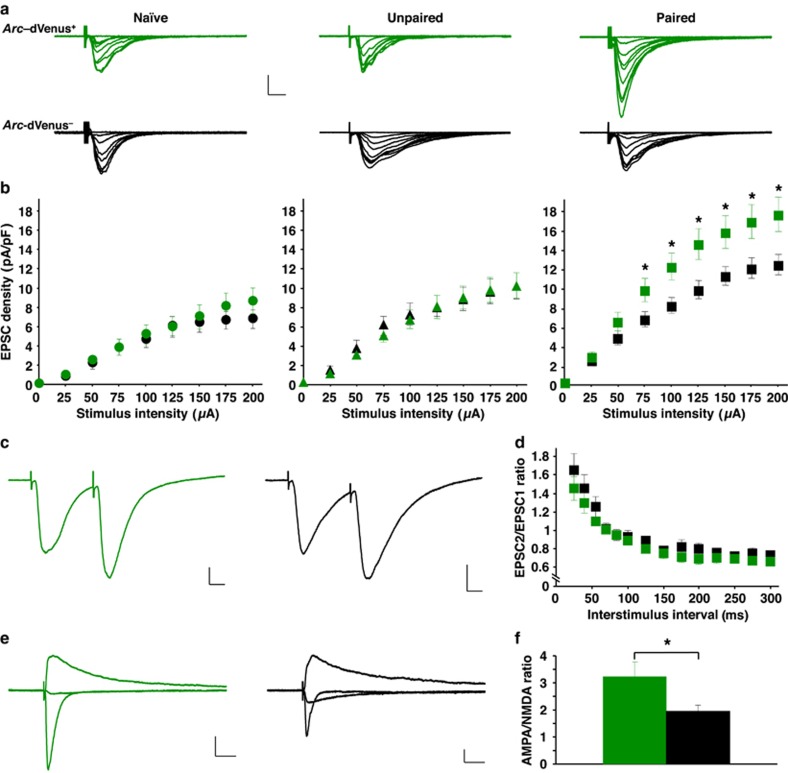
Synaptic potentiation is learning-specific and highly localized to Arc+ neurons. (a) Superimposed averages (5 traces) of EPSCs evoked via thalamic input stimulation (0–200 μA, 25 μA increments) at a holding membrane potential of −70 mV. Stimulus artifacts are truncated. Arc-dVenus+ neurons (top) display strongly potentiated evoked EPSCs specific to the paired (right) versus naïve (left) or unpaired (center) conditions. Scale bars: 200 pA, 10 ms. (b) Input-output curves for naïve (left), unpaired (center) and paired (right) conditions. In the naïve and unpaired conditions, EPSCs recorded from Arc-dVenus+ (naïve: n=13, unpaired: n=19; green) and Arc-dVenus− (naïve: n=14, unpaired: n=18; black) neurons are similar. In contrast, EPSCs are selectively potentiated in Arc-dVenus+ neurons in the paired condition (n=34, green) compared with neighboring Arc-dVenus− neurons (n=34, black), across all stimulus intensities >50 μA. Naïve: n=12 mice, Unpaired: n=12 mice, Paired: n=21 mice. Repeated measures analysis of variance, stimulus intensity × Arc-dVenus interaction: naïve, F=0.88, P=0.39; unpaired, F=0.28, P=0.69; paired, F=5.26, P<0.01. (c) Averages (5 traces) of EPSC pairs (normalized to the first EPSC) with a 45 ms interstimulus interval from Arc-dVenus+ (left) and Arc-dVenus− (right) neurons of mice receiving paired conditioning. Scale bars: 100 pA, 10 ms. (d) Paired-pulse ratios were similar between Arc-dVenus+ (n=14, green) and Arc-dVenus− (n=16, black) neurons from 15 mice. Repeated measures analysis of variance, stimulus intensity × Arc-dVenus interaction, F=1.08, P=0.33. (e) Evoked EPSCs (average of 5 traces) at -70, 0 and +40 mV holding membrane potentials, scaled to the +40 mV peak amplitude. Arc-dVenus+ (left) and Arc-dVenus− (right) neurons from mice receiving paired conditioning. Scale bars: 100 pA, 40 ms. (f) AMPA/N-methyl-D-aspartate ratio is significantly increased in Arc-dVenus+ (n=24, green) compared with neighboring Arc-dVenus− (n=26, black) neurons from 15 mice. *P<0.05.